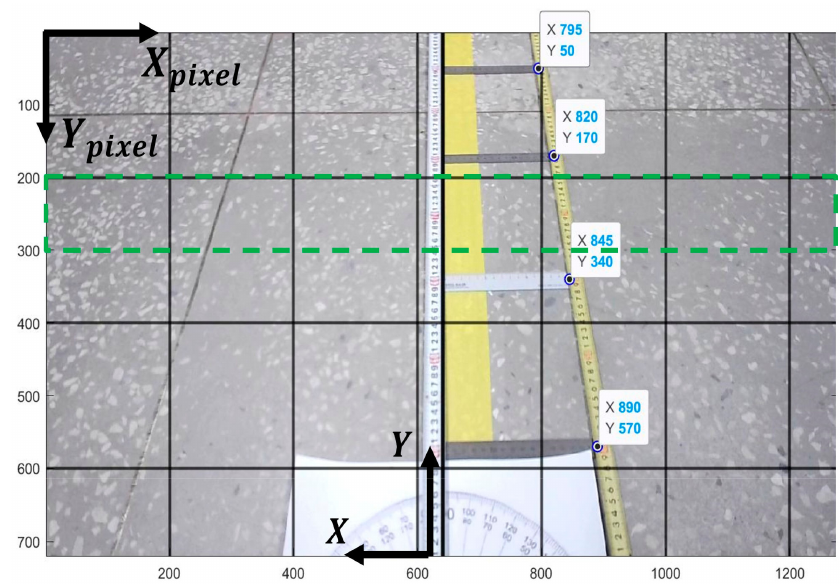
Figure 3. Conversion of pixel to actual distance in